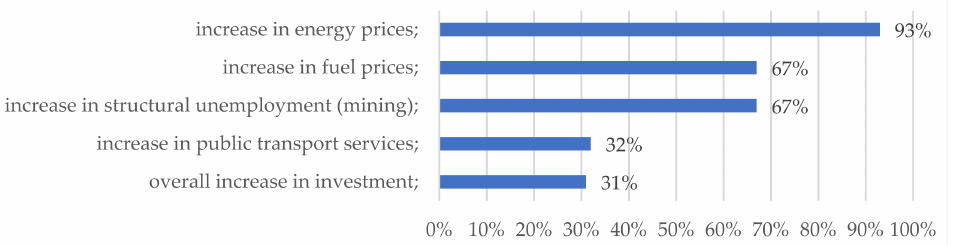
Figure 12. Statistics of responses to the question: Which sectors of the economy are most vulnerable to the impact of decarbonization policies?